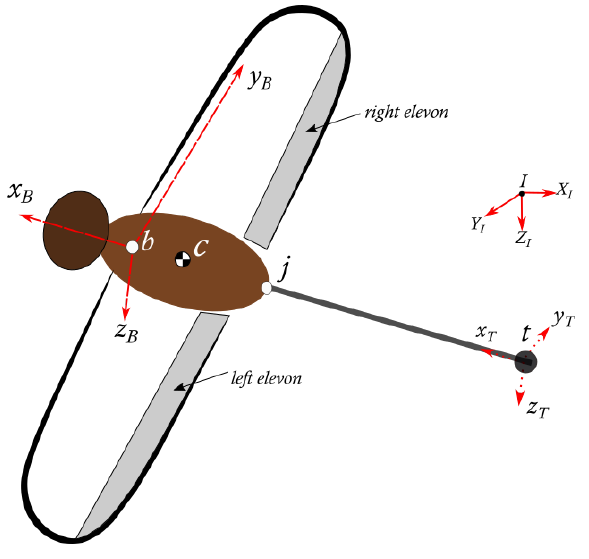
Figure 3. Definition of coordinate systems: Inertial (I), Body (B) and Tail